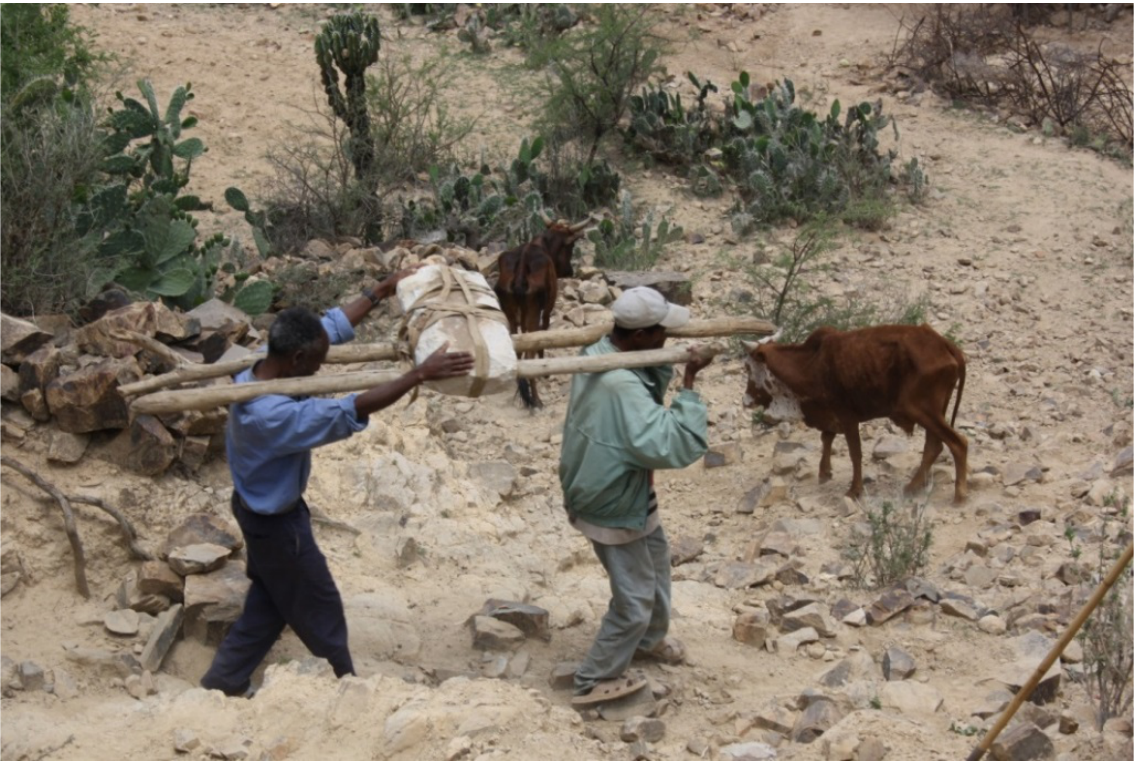
Figure 14. Men transporting the mațhan (quern) using a